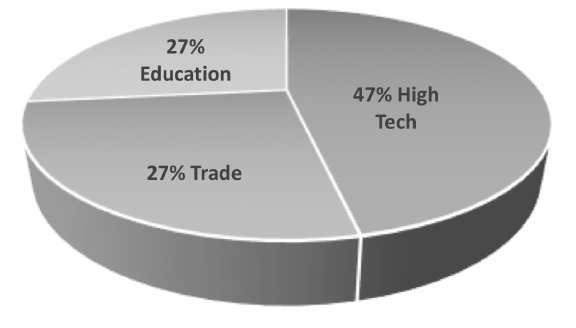
Fig. 2. Organization Type